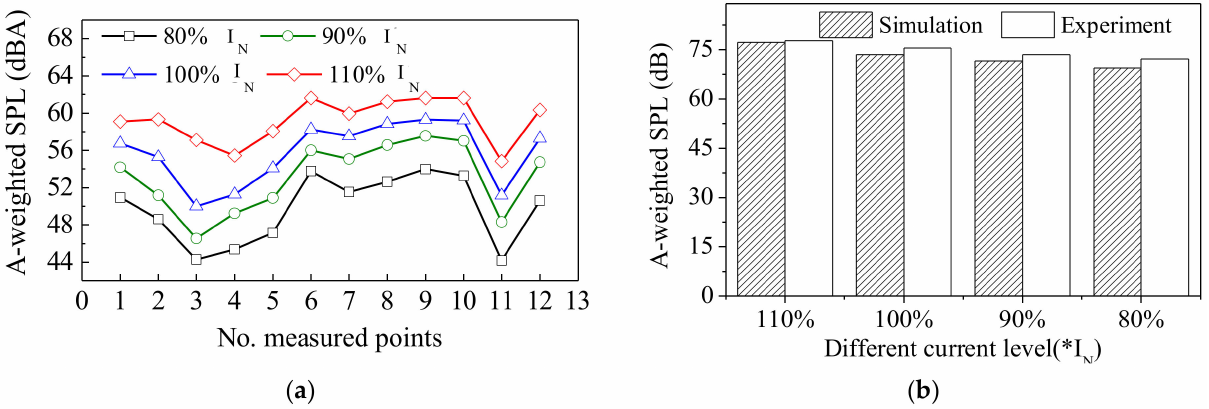
Figure 22. Comparison of A-weighted SPL under different load conditions. ( a ) ASPL at each point; ( b ) Average equivalent